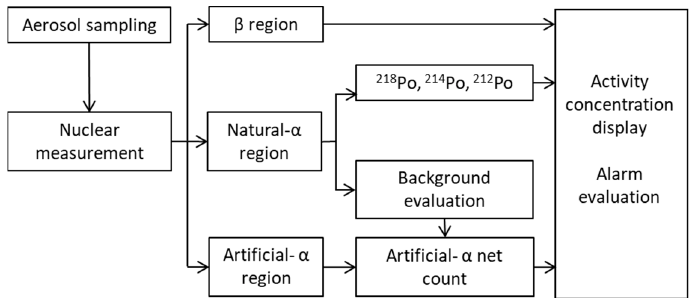
Figure 3. Illustration of the CAM measurement processes from aerosol sampling to activity concen- tration display.